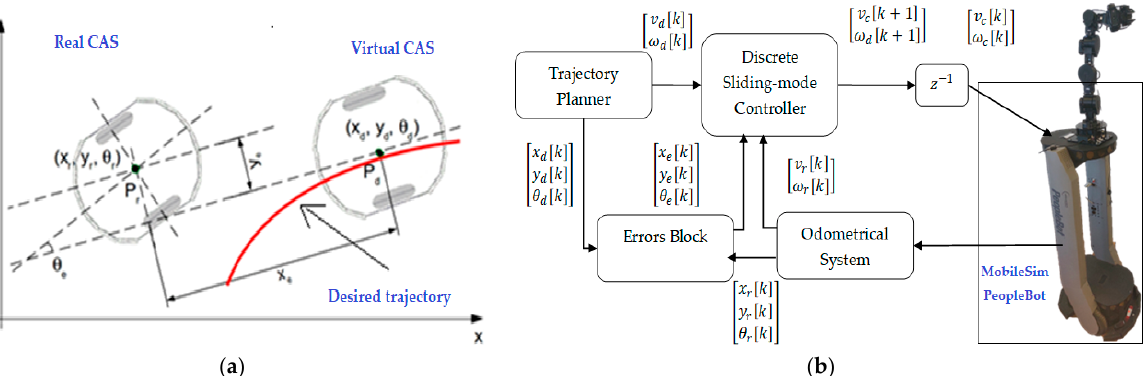
Figure 16. ( a )-Real and virtual CAS along the desired trajectory, ( b )-CAS closed loop control in MobileSim or physically. Sensors 2022 , 22 , 8153